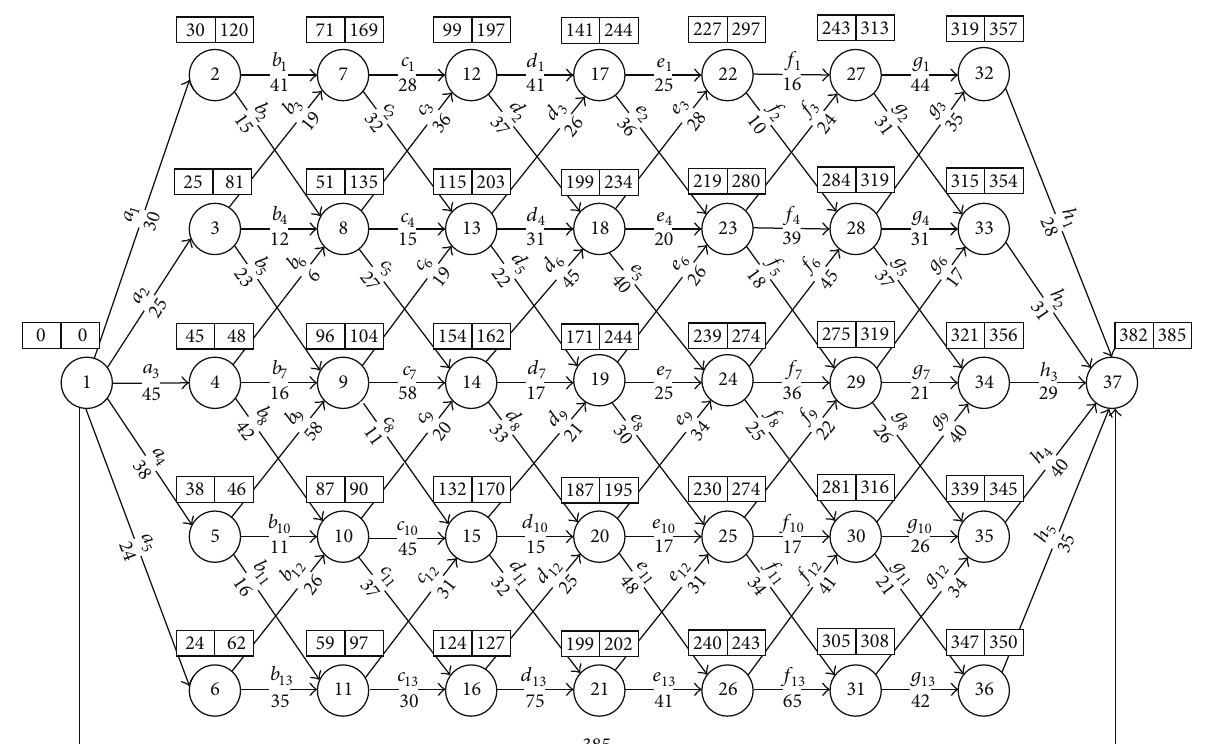
Figure 5: Time parameters for all activities with their shortest durations.